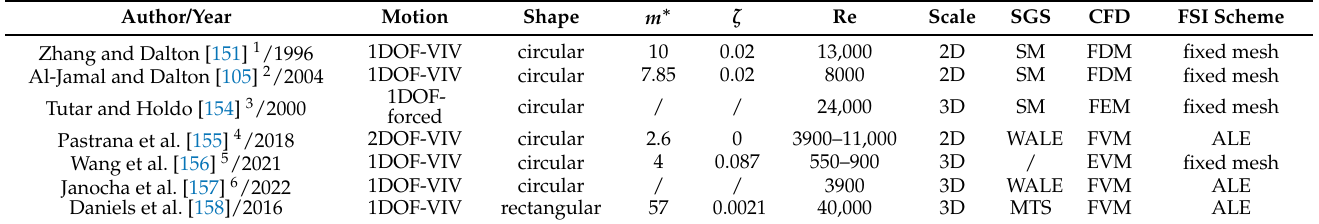
Table 3. Summary of LES studies of the flow-induced vibration of a bluff